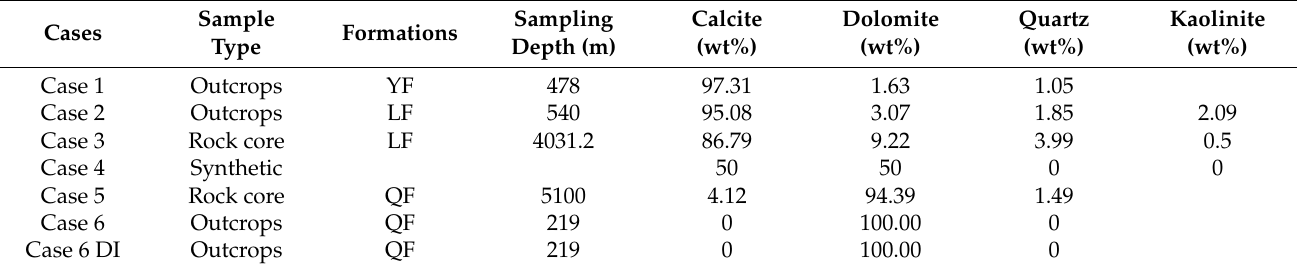
Table 1. Mineral composition of rock samples before experiments.